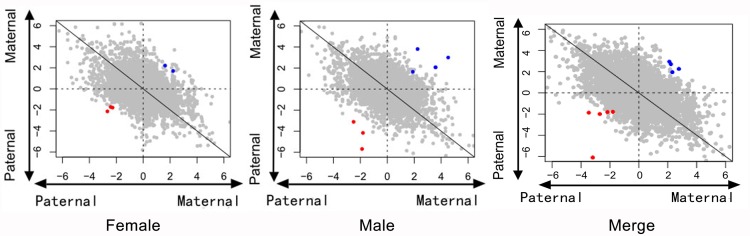
Ratio of reads aligned to parental genomes of all SNPs.Points in this figure reflect the ratio of reads aligned to the maternal versus the paternal genomes under the loose standard (SNP sequencing depth greater than 2×). The horizontal axis is log2 (m:f) in cross I, while the vertical axis is log2 (m:f) in cross II. Red points indicate the candidate maternal imprinted SNPs, while the blue points indicate candidate paternal imprinted SNPs.